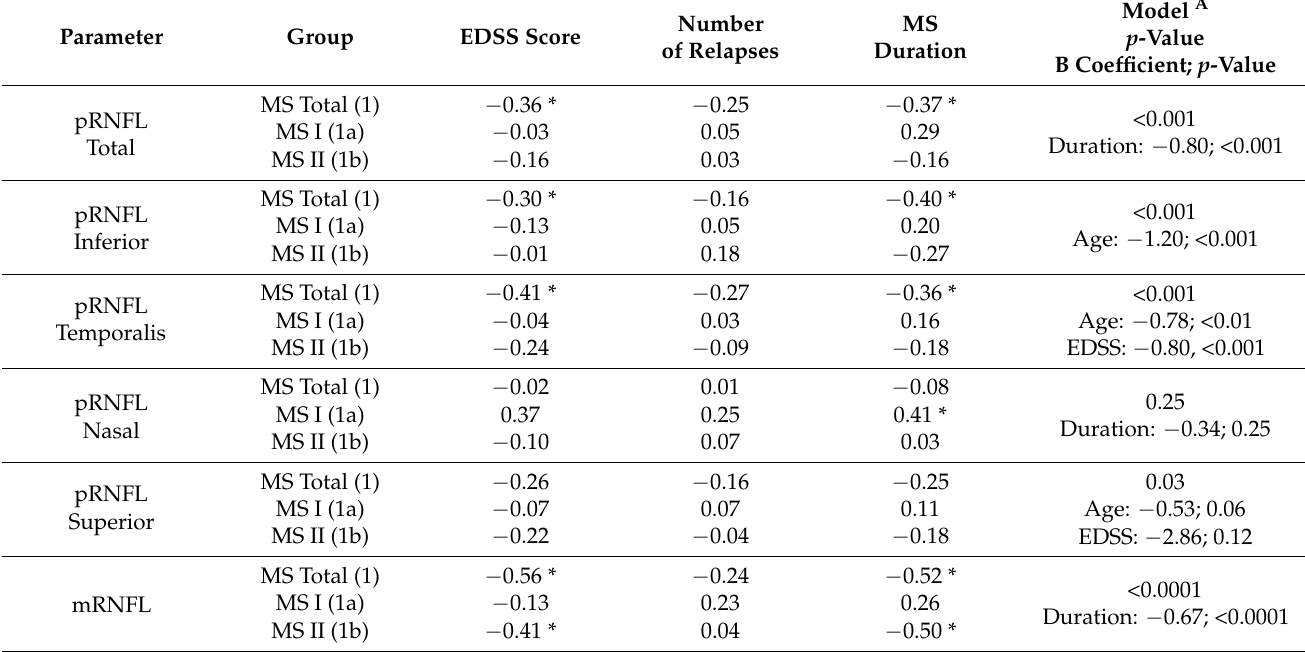
Table 8. Correlation between the OCT parameters and EDSS score, number of relapses, MS duration (time from first